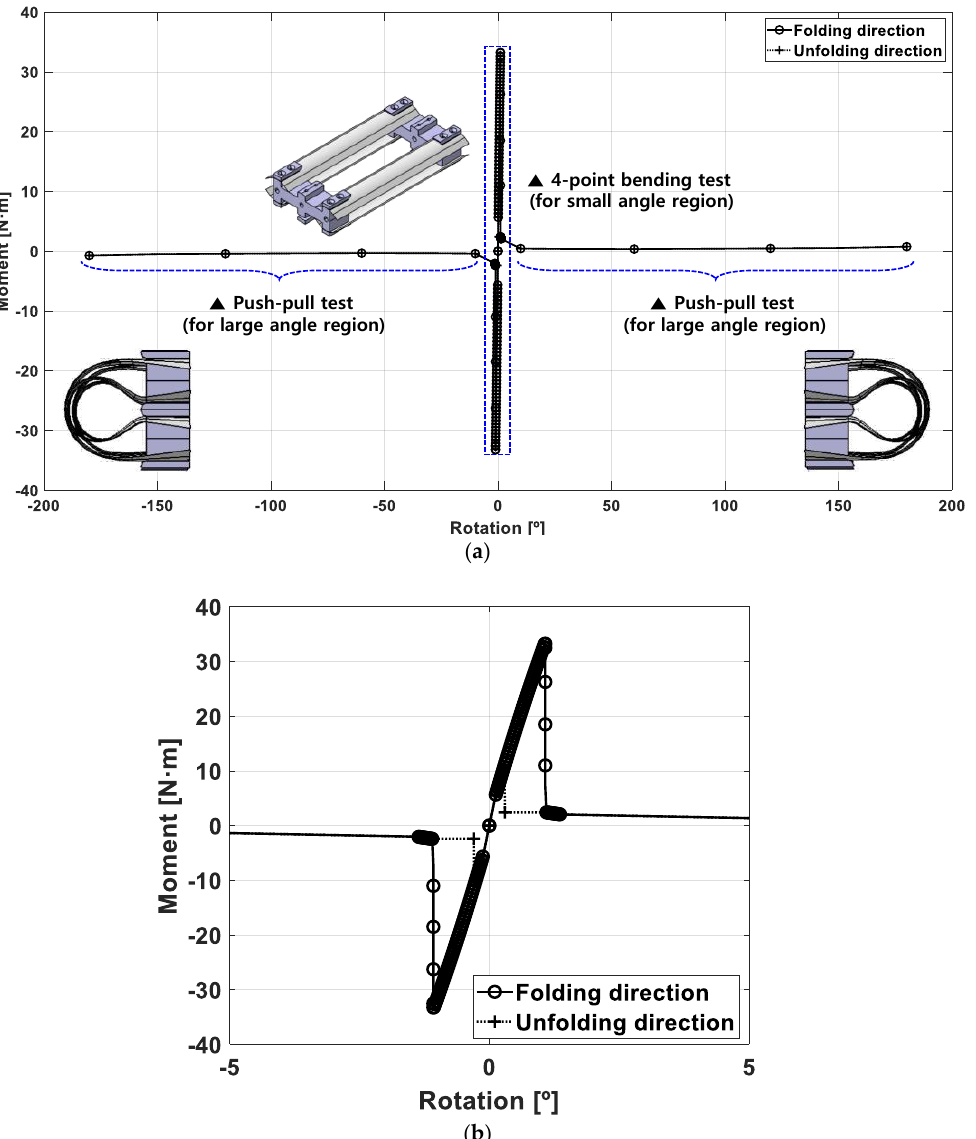
Figure 4. Measurement results of the moment – rotation profile: ( a ) for all rotation angle ranges, ( b ) for small-angle ranges.